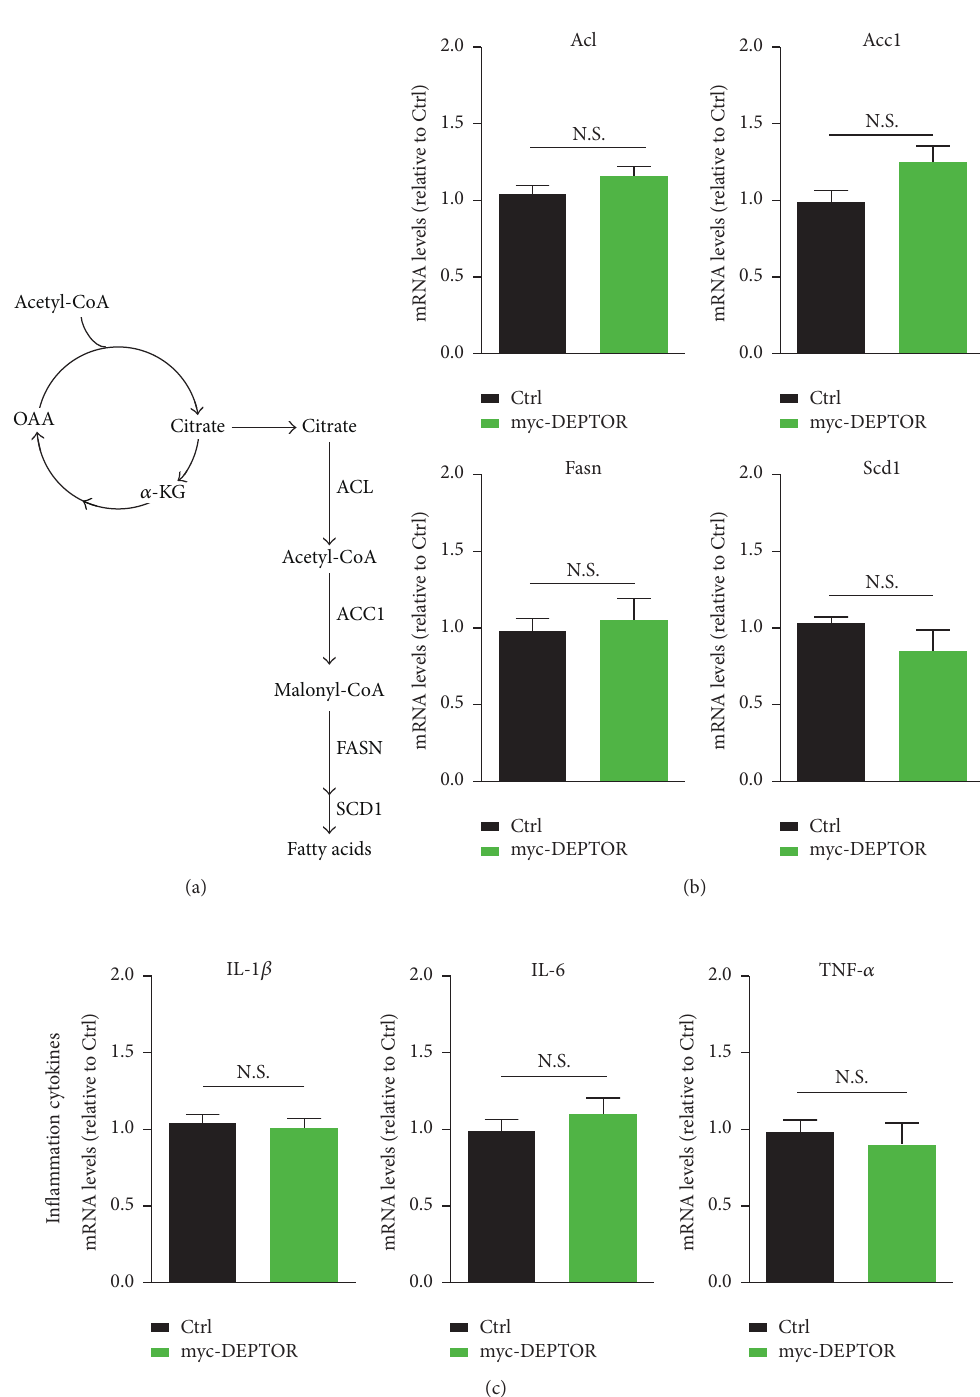
Figure 2: Overexpressed DEPTOR does not inhibit lipogenesis and inflammation. (a) A schematic model showed the signaling of mTORC1- controlled lipogenesis. ACL, ACC1, FASN, and SCD1 were downstream enzymes in fatty acid synthesis. (b) Real-time RCR results showed that mRNA levels of lipogenesis genes, including Acl, Acc1, Fasn, and Scd1, were not reduced in DEPTOR overexpressed cells. Results are averages of three independent experiments. Data represent mean ± SEM. N.S.: no statistical significance. (c) Real-time RCR results showed that mRNA levels of inflammation genes, including IL1- 𝛽 , IL-6, and TNF- 𝛼 , were not reduced in DEPTOR overexpressed cells. Results are averages of three independent experiments. Data represent mean ± SEM. N.S.: no statistical